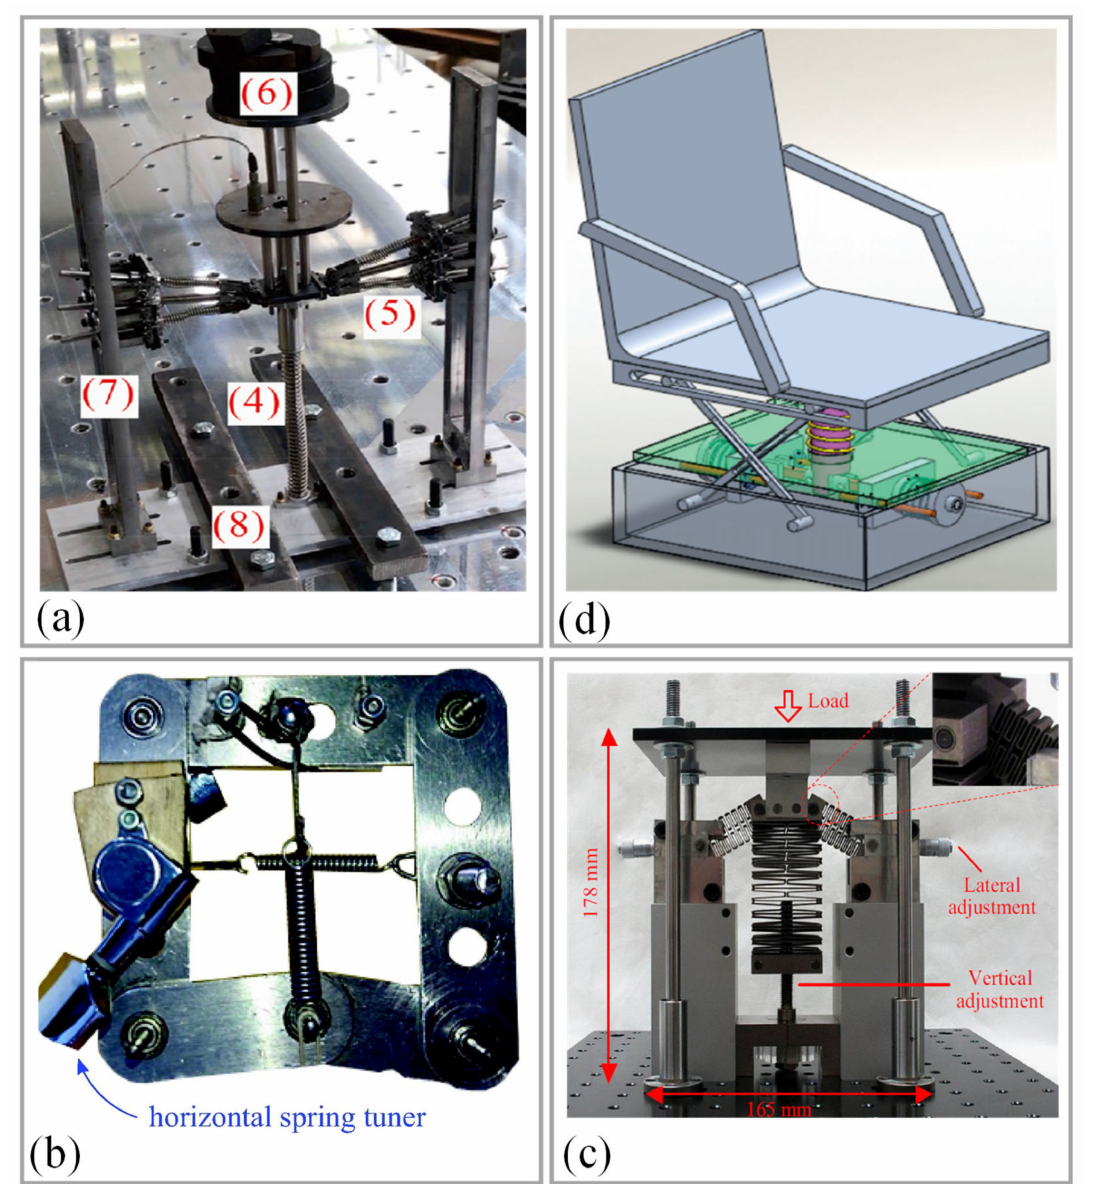
Figure 9. Representative applications and experimental prototypes of QZS vibration isolators using mechanical springs: ( a ) the experimental prototype of QZS vibration isolator with a multi-spring structure proposed by Zhao et al. [8–10]; figure adapted with permission from Ref. [9]. Copyright 2021, copyright Zhao, F.; (4)-the vertical spring to generate positive stiffness, (5)-three pairs of oblique springs to generate negative stiffness, (6)-isolation platform and loaded mass, (7)-supporting frame, (8)-fixture; ( b ) The mechanically simple quasi-zero stiffness device is designed by Gatti et al. [15,16]; figure adapted with permission from Ref. [16]. Copyright 2021, copyright Shaw, A.D.; ( c ) The vibration isolator capable of isolating a wide range of loads is proposed by Lan et al. [21]; figure adapted with permission from Ref. [21]. Copyright 2014, copyright Lan, C.C.; ( d ) The typical QZS vibration isolator with a slider block–guide rod structure proposed by Danh Le et al. [23,24], which is applied to seat suspension of vehicles; figure adapted with permission from Ref. [23]. Copyright 2011, copyright Le,